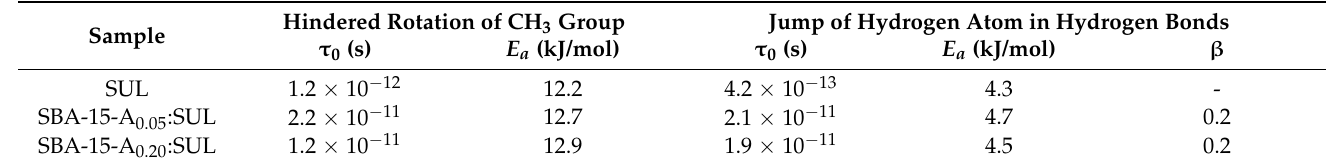
Table 1. Motional parameters obtained for SUL, SBA-15-A 0.05 :SUL, and SBA-15-A 0.20 :SUL. The values of uncertainty of the estimated parameters were lower than 10%.